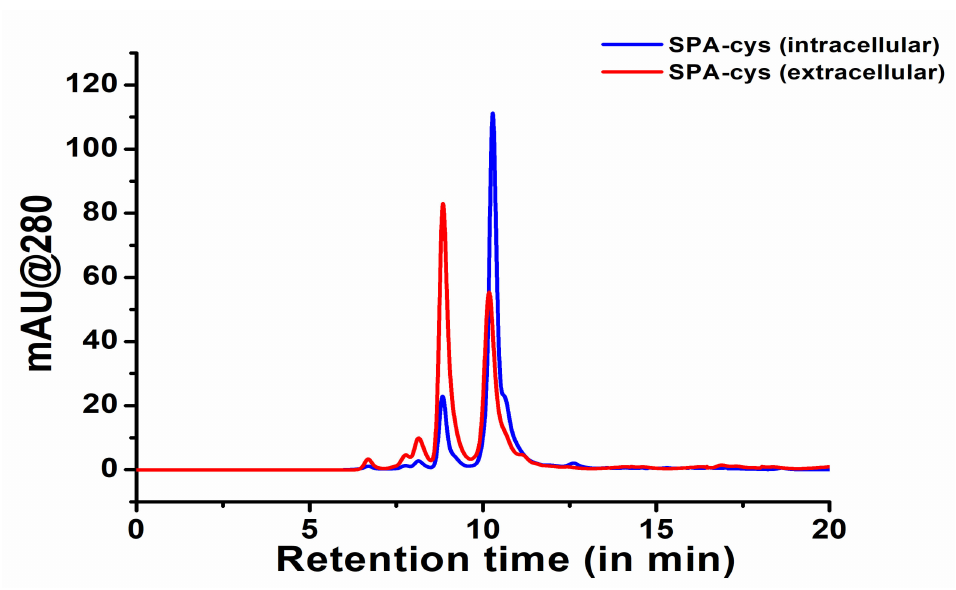
Figure 3. SEC-HPLC graph showing peaks of Strain 3: SPA-cys intracellular (blue) and Strain 4: SPA-cys extracellular (red) with monomeric and dimeric form. Table 3. SEC-HPLC table showing retention time, peak area, and peak area percentage in monomeric and dimeric